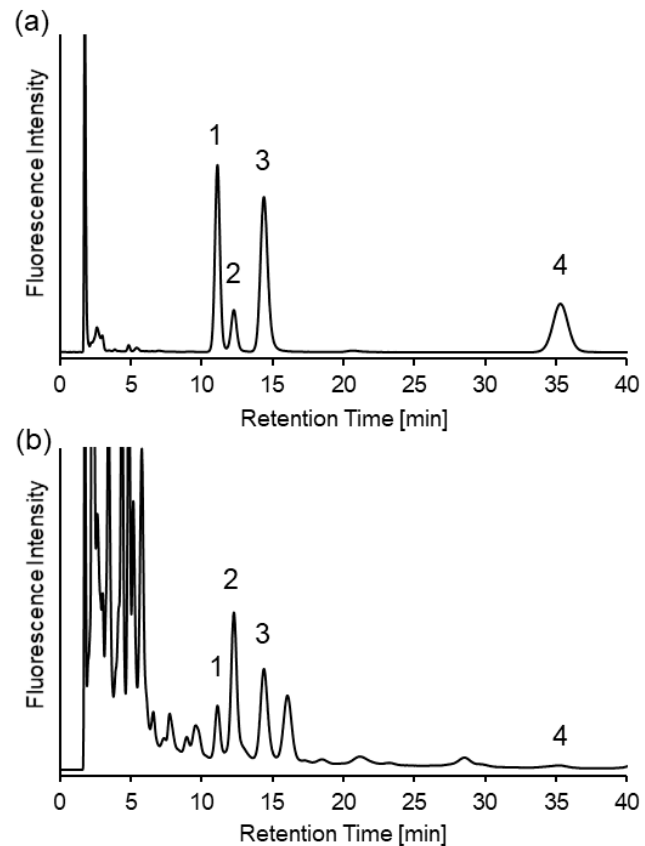
Figure 4. Chromatograms of ( a ) 1 µM SBD-thiols standard solution and ( b ) mouse urine samples under optimized conditions. Mobile phase—acetonitrile / 120 mM ammonium formate (pH 3.0) (81:19). Peaks—1, SBD-Hcy; 2, SBD-Cys; 3, SBD-CysGly; 4, SBD-GSH.